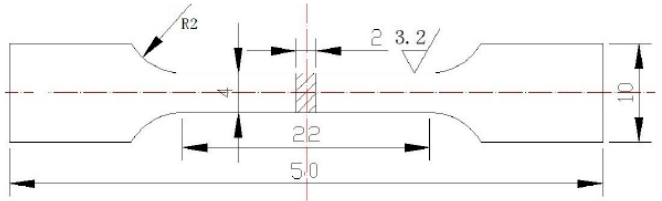
Figure 4. The dimensions of the stretched pattern.